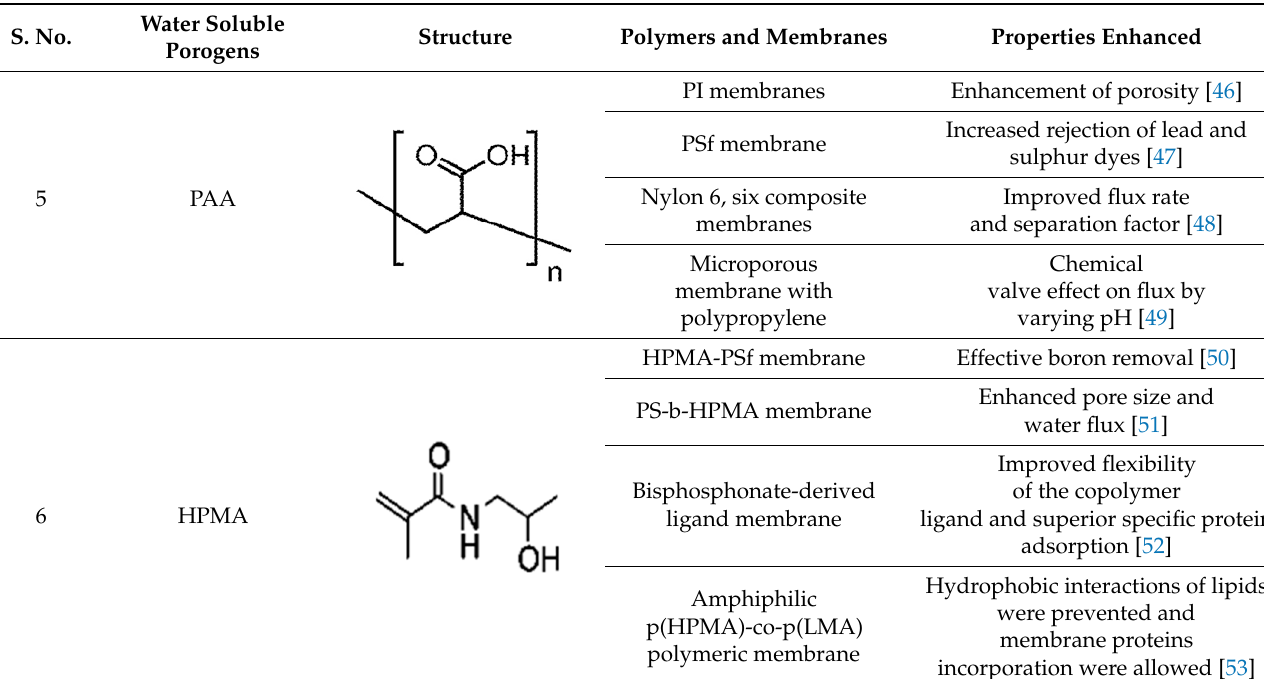
Figure 7. SEM microstructures of 10 wt.% PES/DMF/6 wt.% PVP K17 MCs prepared by using the phase inversion technique: ( a ) surface (100×), ( b ) surface magnification (20,000×), ( c ) cross-section (100×), and ( d ) magnified cross-section (500×) [54]. 4.2. Ionic Liquids as Porogens In a similar investigation, ionic liquids (IL) were explored for the pore formation pro- cess in polymer membranes and microspheres using the phase inversion technique. Any tailor-made material fabrication process requires meticulous planning where each com- ponent fulfils an active role in determining the size, morphology, stability and application. A membrane or microsphere (MC) that is composed of ILs and polymers as core compo- nents without physical/chemical interaction generates the final products. In the case of ionic liquids, physico-chemical properties (viscosity, density, etc.), nature (carbon chain length, cations and anions), toxicity, cost and availability are considered as crucial factors. The choice of the materials (membrane, microsphere) was based on destined applications, such as separation, adsorption (organic, inorganic compounds), target delivery, loading of different chemicals, etc. However, the novel composite materials using IL incorporated MCs as porogens showed a higher uniformity compared to that of microspheres without IL. These may cre- ate varied opportunities for the preparation of extraction capsules and microreactors with a smaller size and with a mean diameter value of 1.1 mm (Figure 8) [55].